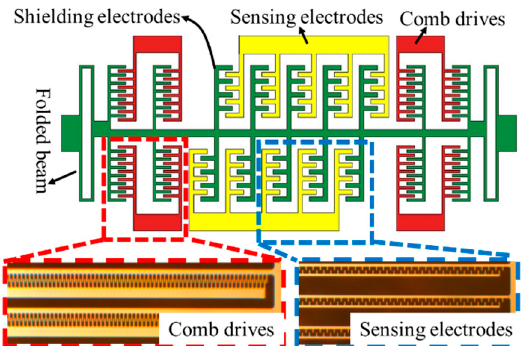
Figure 1. Sketch and pictures of the electric field microchip.